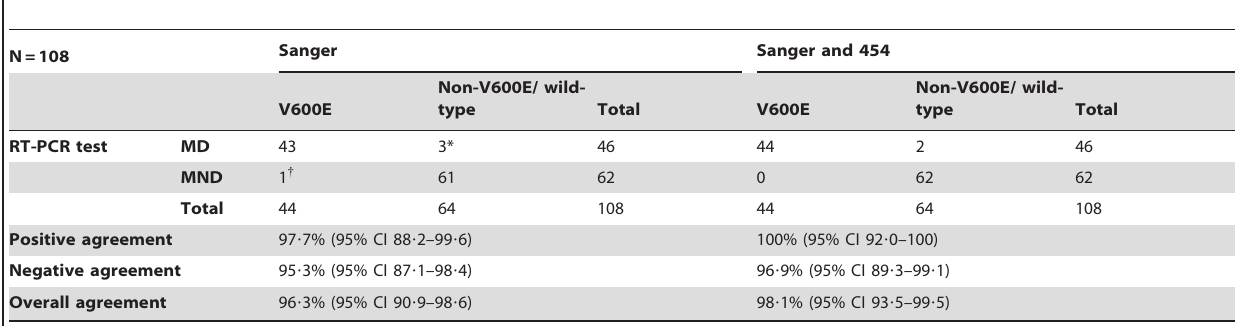
Table 3. Methods correlation between RT-PCR test and Sanger at Site 1 and after 454 sequencing of discrepant specimens.